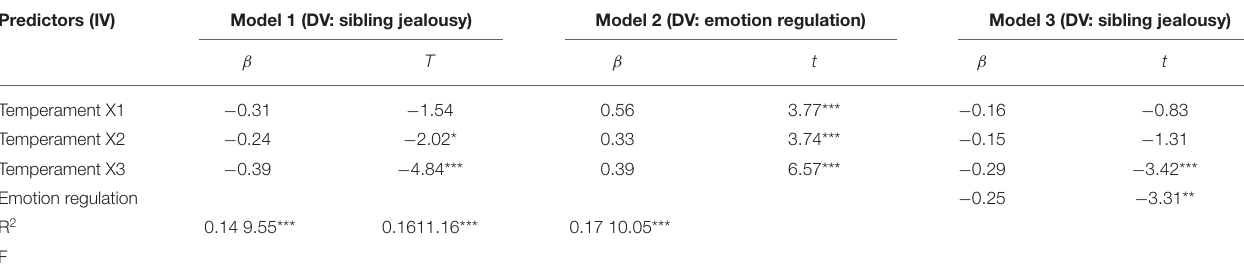
TABLE 2 | Testing the mediation effect of emotion regulation on sibling jealousy. Predictors (IV) Model 1 (DV: sibling jealousy) Model 2 (DV: emotion regulation) Model 3 (DV: sibling jealousy) β T β t β t Temperament X1 − 0.31 − 1.54 0.56 3.77*** − 0.16 − 0.83 Temperament X2 − 0.24 − 2.02* 0.33 3.74*** − 0.15 − 1.31 Temperament X3 − 0.39 − 4.84*** 0.39 6.57*** − 0.29 − 3.42*** Emotion regulation − 0.25 − 3.31** 0.14 9.55*** 0.1611.16*** 0.17